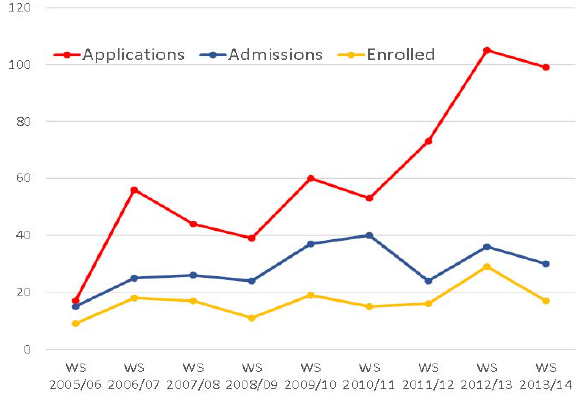
Figure 2. ESPACE applications and admissions WS 20005/06